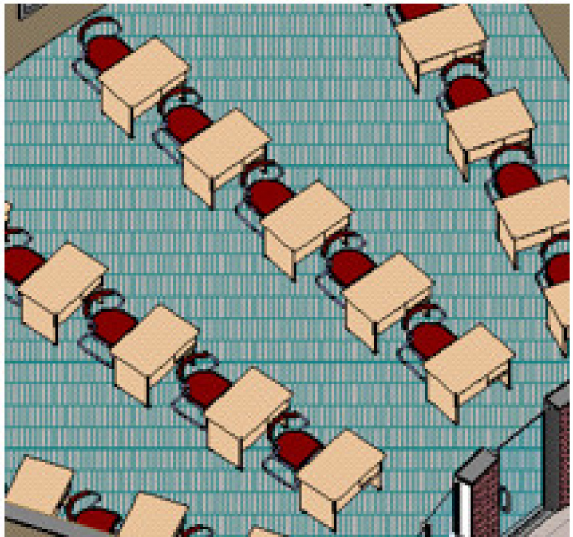
Figure 5. Reading room in the BIM model.